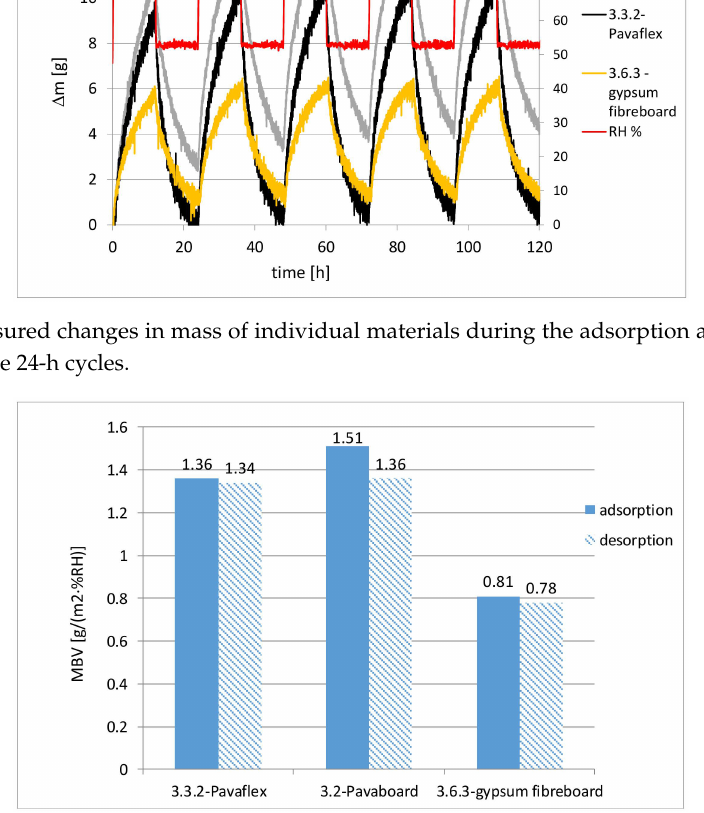
Figure 8. Moisture bu ff er values for individual